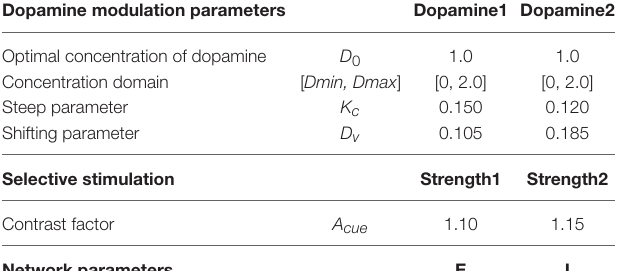
TABLE 1 | Parameters used in the model.